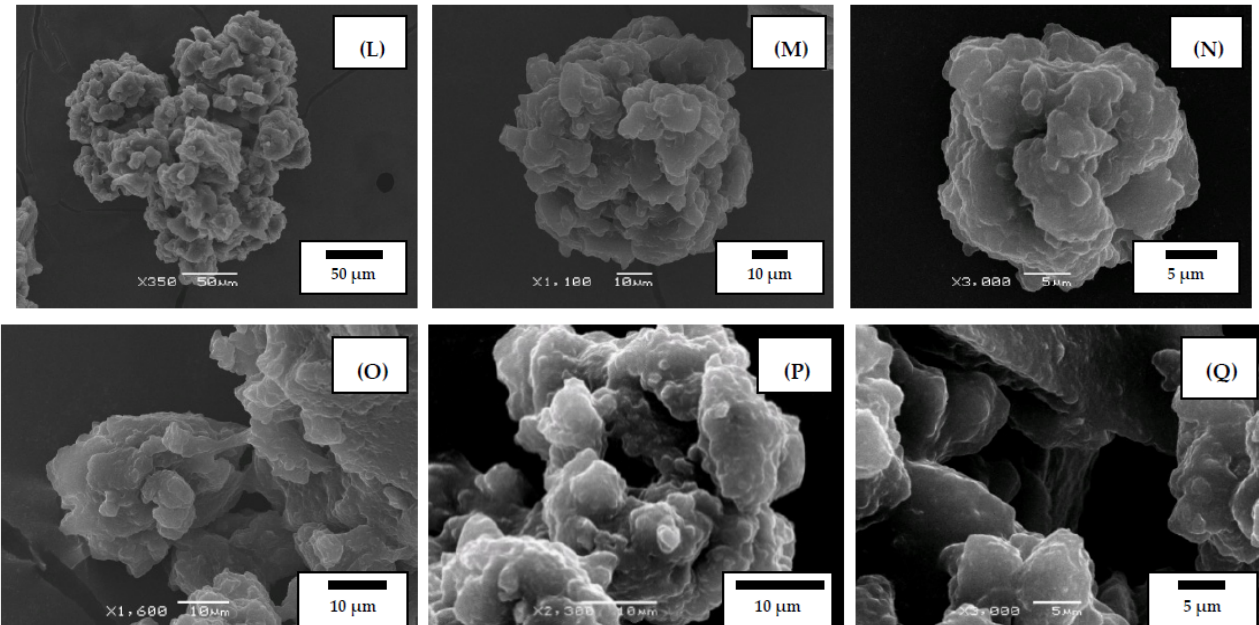
Figure 1. ( A – F ) SEM images of crumb rubber particles obtained by roll grinding; ( G – H ) SEM images of the general view of the APDDR particles; ( I – N ) SEM images of specific APDDR particles; ( O – Q ) SEM images of the APDDR particle segments.